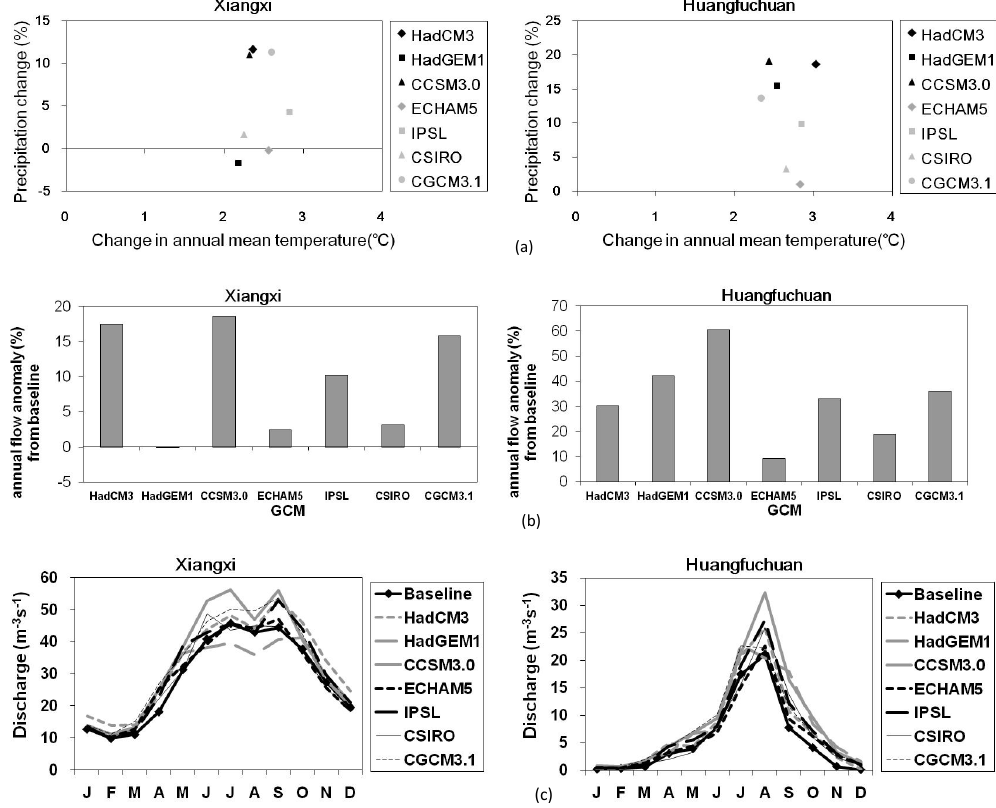
Fig. 6. (a) Projected changes in annual mean temperature ( ◦ ) and annual precipitation (%), (b) annual and (c) monthly discharge under 2 ◦ Fig.6. (a) Projected changes in annual mean temperature ( ℃ ) and annual precipitation (%), (b) annual and (c) monthly discharge under 2 ℃ warming scenarios across 7 warming scenarios across 7 GCMs